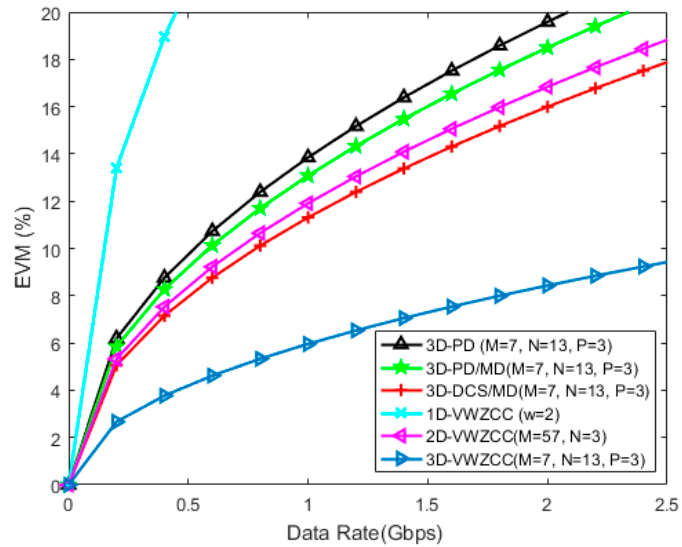
Figure 14. EVM versus data rate when the number of active users K = 250 and effective source power P sr = − 10 dBm.